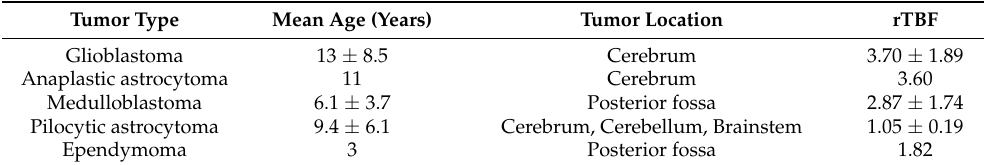
Table 10. Relative tumor blood flow (rTBF) values in different pediatric tumors, age of patients, and tumor location